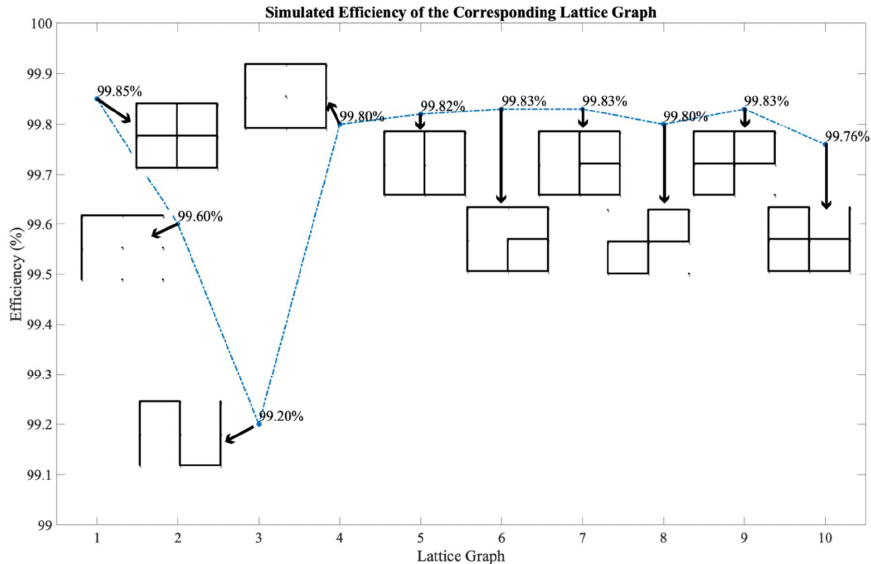
Figure 15. Simulated efficiencies of corresponding lattice graphs.